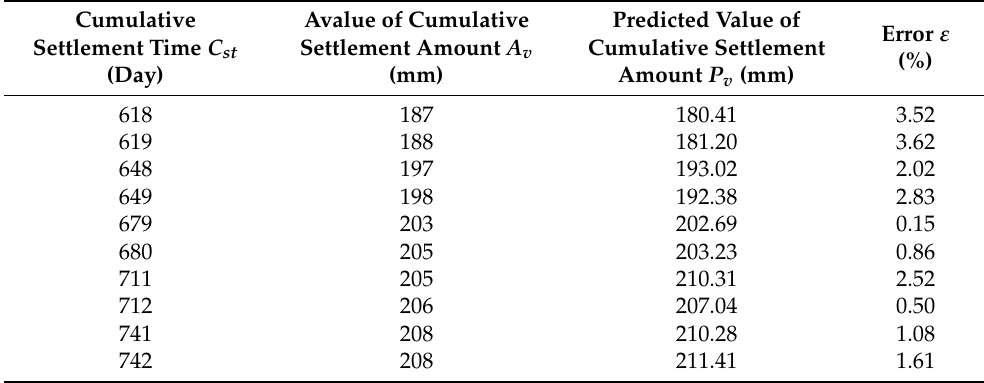
Table 2. Comparison between predicted and actual value of soft soil settlement of test